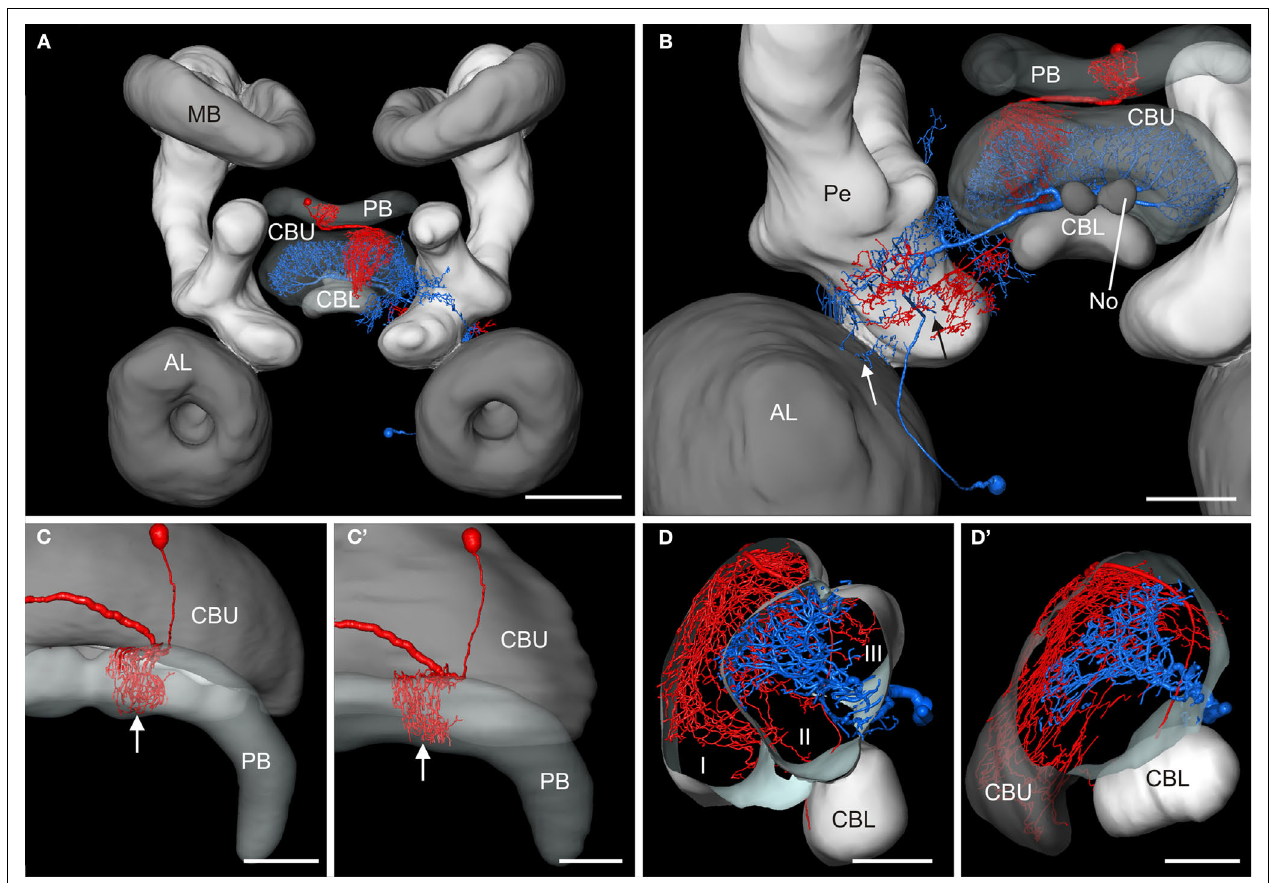
FIGURE 8 | Registration of the CPU1a (red) and GFS (blue) neurons into the ISA standard brain and into the standard central complex. (A) Anterior view of the central brain of the standard brain showing the central complex, the mushroom bodies (MB) and the antennal lobes (AL). (B) Postero-lateral view of the central standard brain. Arrows indicate displacement of arborizations of the GFS neuron into the pedunculus (Pe) and antennal lobe. (C,C’) Dorsal view showing cell body and ramifi cations of the CPU1a neuron in column R7 (white arrows) of the protocerebral bridge (PB) registered into the